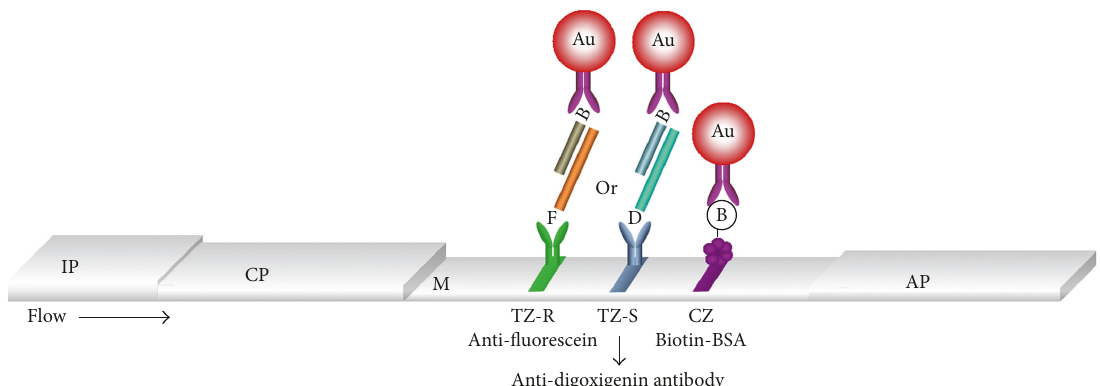
Figure 1: Principle of the dual nanoparticle-based lateral flow biosensor for simultaneous detection of nodavirus SJNNV and RGNNV genotypes. Two test zones (anti-fluorescein antibody (TZ-R) and anti-digoxigenin antibody (TZ-S)) and a control zone (biotinylated BSA (CZ)) have been deposited on the diagnostic membrane. The sample, containing the respective genotype of the target analyte (tetra-primer PCR product with fluorescein (F) for RGNNV genotype or digoxigenin (D) for SJNNV genotype), is hybridized with a biotinylated genotype-specific oligonucleotide probe and applied on the conjugation pad, where functionalized gold nanoparticles (Au) with anti-biotin antibody have already been added. Following that, the biosensor is immersed in the developing buffer, the sample and the nanoparticles are immobilized on the appropriate test zone, and the positive signal is visible by the naked eye, as a red zone. The excess nanoparticles bind to the control zone of the biosensor. The image shows a side view of the lateral flow biosensor. IP: immersion pad; CP: conjugation pad; M: diagnostic membrane; AP: absorbent pad. The assay components are not in